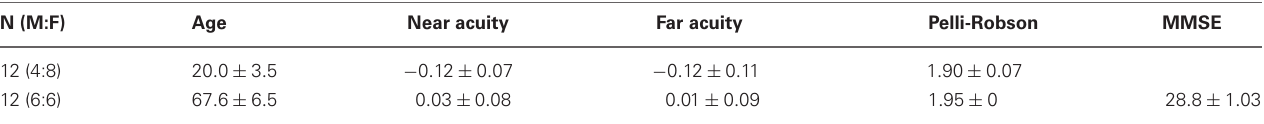
Table 2 | Experiment 3: Mean ± 1SD age, near and far logMAR acuity, Pelli-Robson contrast sensitivity, and mini-mental state examination